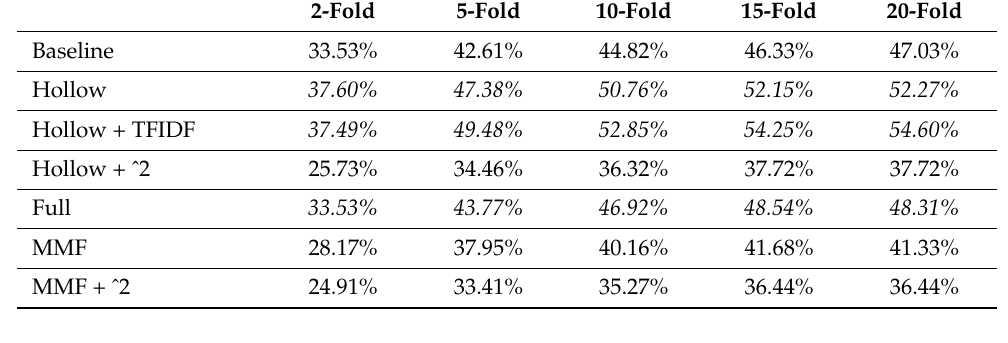
Table 1. Classification accuracy of each feature representation method.